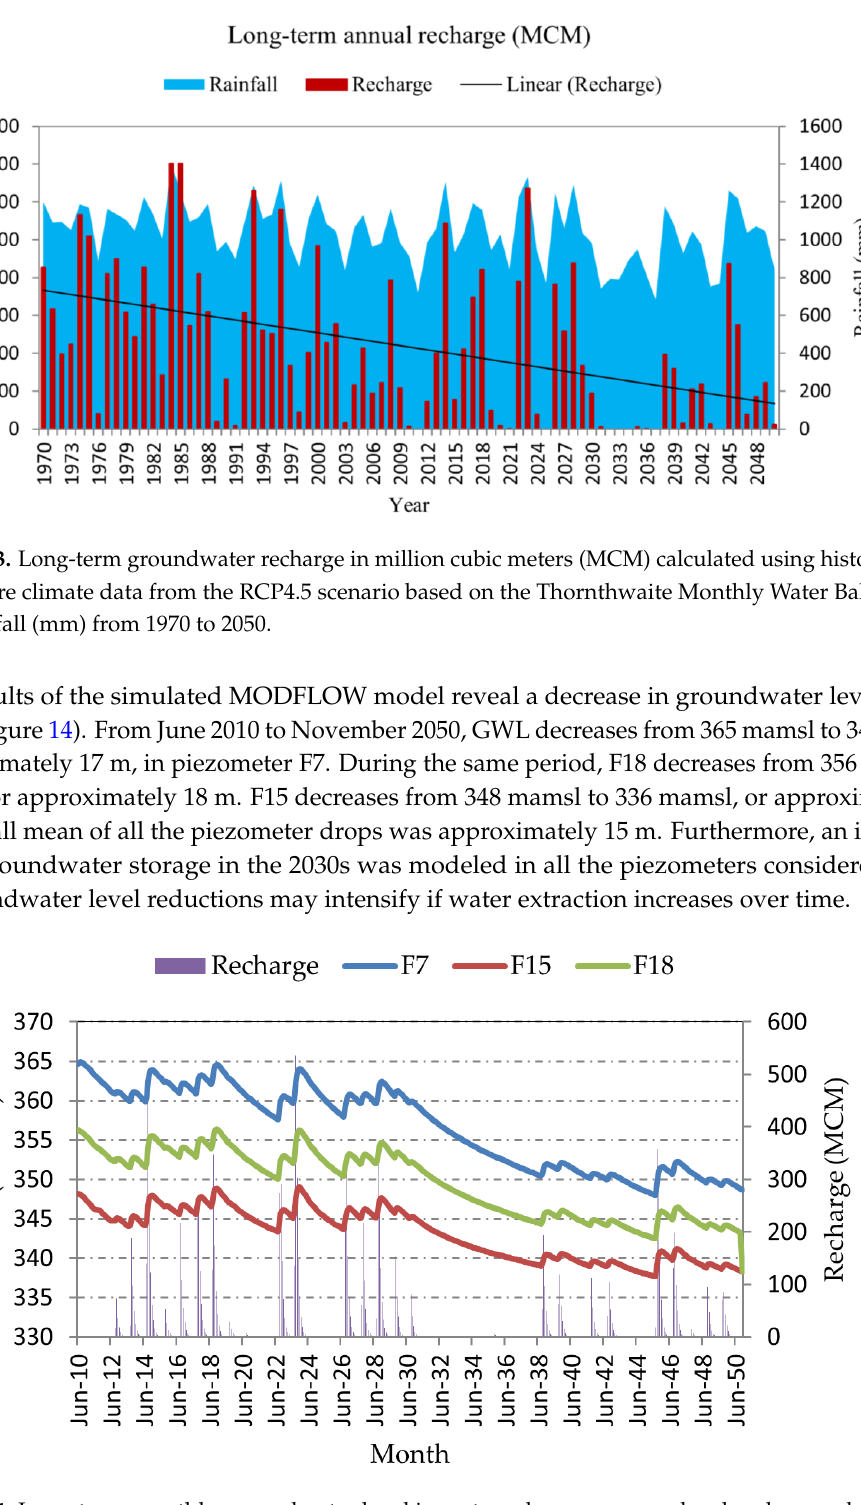
Figure 14. Long-term monthly groundwater level in meters above mean sea level and groundwater recharge (MCM) in the Klela basin calculated using RCP4.5 climate data from June 2010 to November 2050.